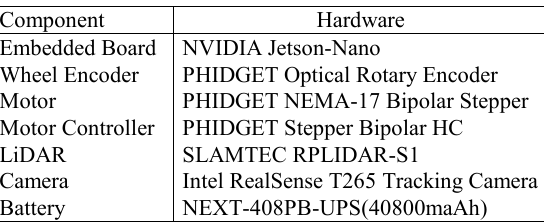
Table 1 . Pallet robot’s hardware spec sheet